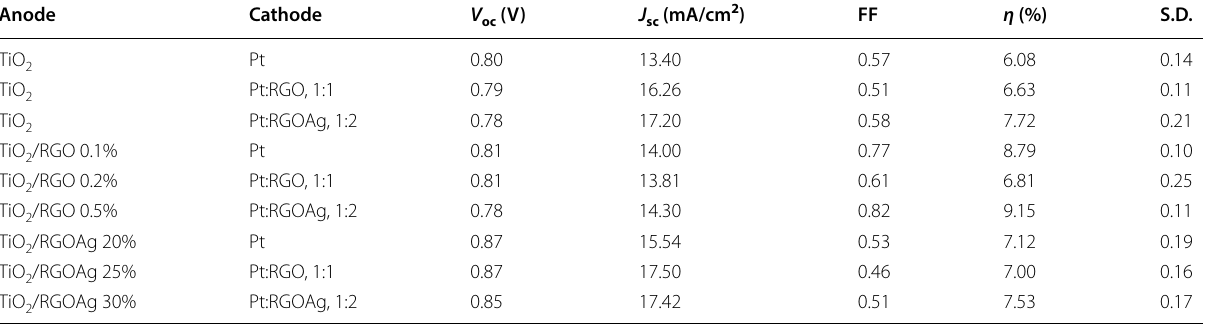
Table 4 Anode cell preparation by double-screen screen printing Anode cells (TiO 2